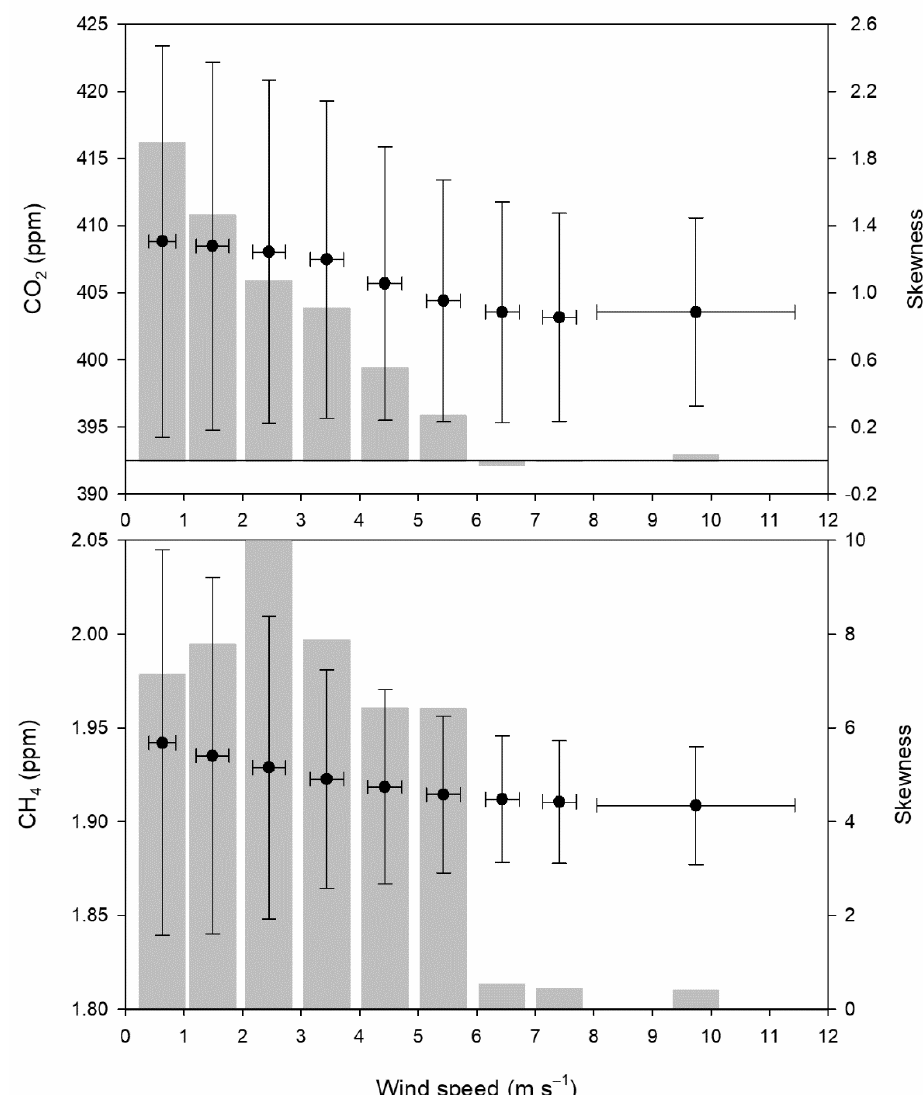
Figure 4. Means, standard deviations, and skewnesses of the concentrations.